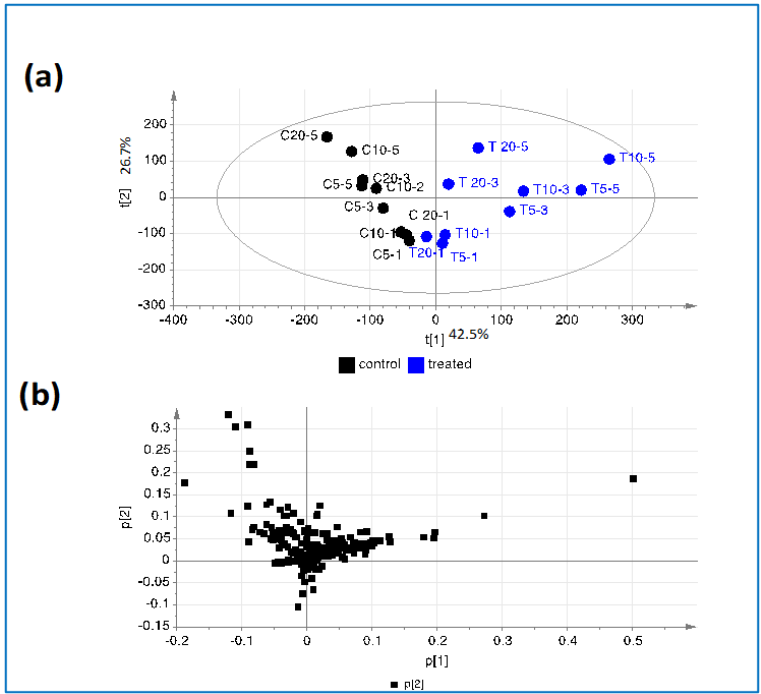
Figure 1. Principal component analysis of control cells (C) and cells pre-incubated with wine extract (T), according to their metabolite levels: ( a ) score plot and ( b ) loading plot. To set up the experi- mental procedure, 5, 10, and 20 millions of cells were used, and 1, 3, and 5 μ l of cell extract were analyzed.